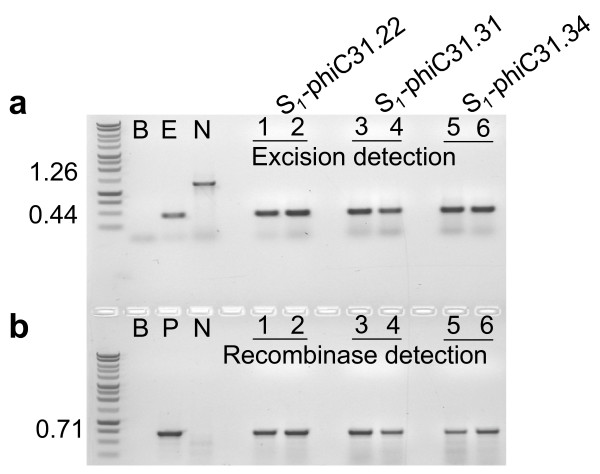
PCR analysis for site-specific recombination and the presence of the phiC31 gene in the MC1 generation. a) PCR reactions with primers e and f (Fig. 1) or b) with primers g and h (Fig. 1) on manually crossed lines; (lanes 1, 2) MC1-phiC31.22.3, 22.15; (lanes 3, 4) MC1-phiC31.31.40, 31.83; (lane 5, 6) MC1-phiC31.34.9, 34.20. Control lanes are B (blank, no DNA); E (excision, pN3-phiC31exc); N (no excision, pN3-phiC31); P (recombinase, pCOXS3-phiC31).